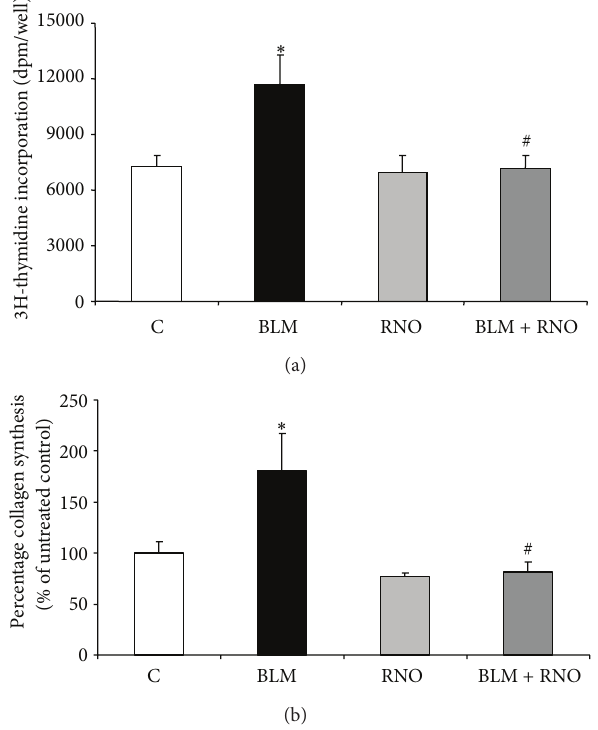
Figure 1:Effect ofBLMand RNOon HLFproliferation andcollagen synthesis. HLF were preincubated or not with RNO (2nM) for 30 min and then treated with BLM (50mU/mL). (a) Cell prolifera- tion was evaluated on HLF from three different donors after 24h by measuring [ 3 H]-thymidine incorporation. Results are expressed as [ 3 H]-thymidine incorporation (dpm) per well. Each sample was run in quadruplicate. Data are mean ± SD of 3 experiments. ∗ 𝑃 < 0.05 versus control (C); # 𝑃 < 0.05 versus BLM. (b) For determination of [ 3 H]-proline incorporation into collagen and noncollagen proteins, media were harvested after 48 h of treatment. Results are presented as percentage of untreated control. Data are mean ± SD of 3 experiments each in quadruplicate. ∗ 𝑃 < 0.05 versus control (C); # 𝑃 < 0.05 versus